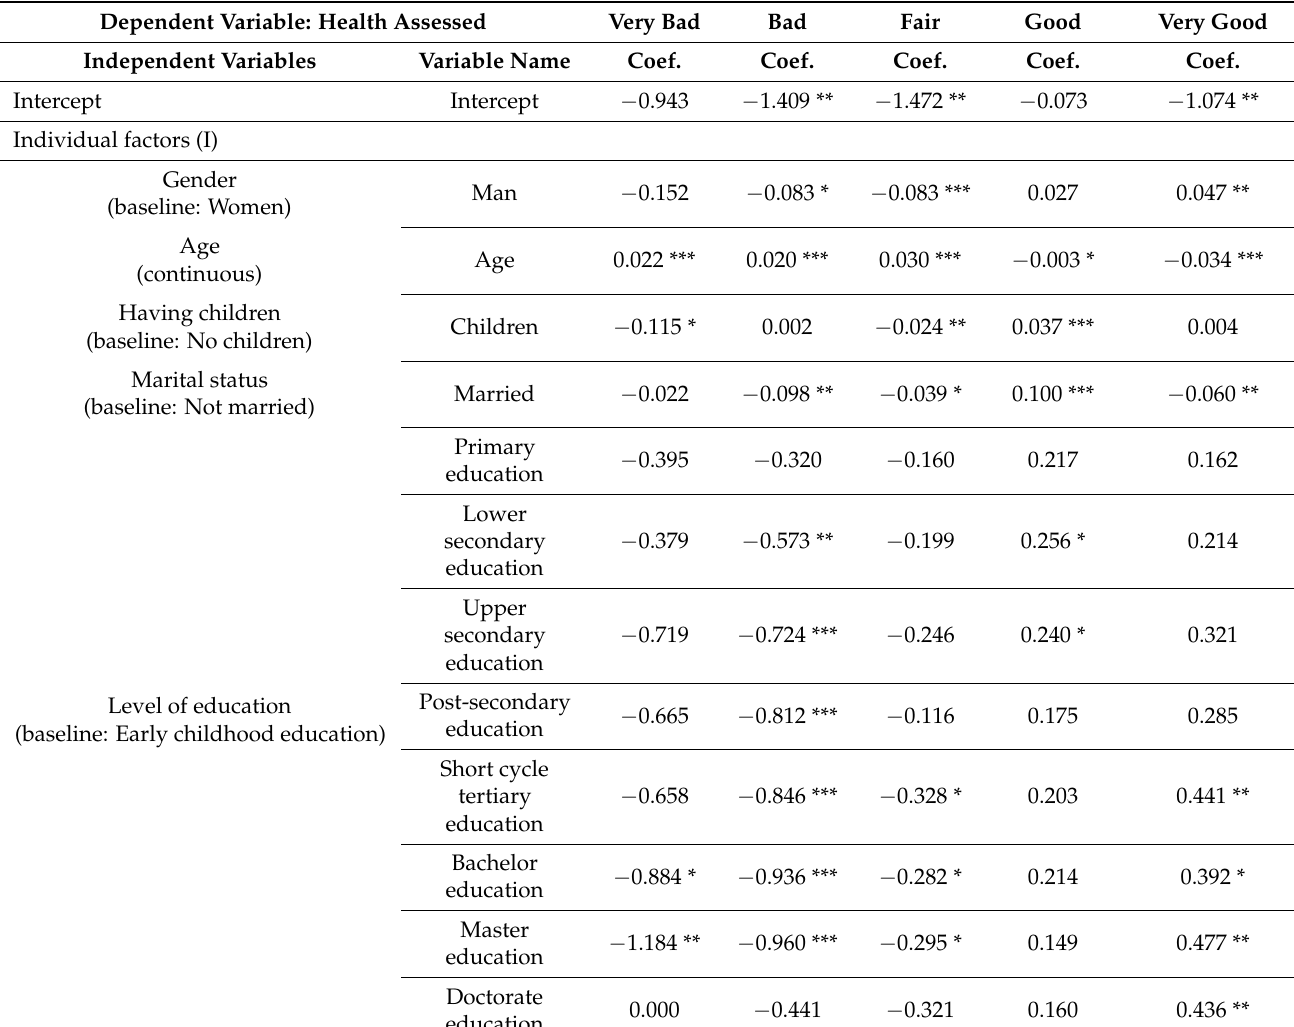
Table 3. Probit regression results for the unemployment